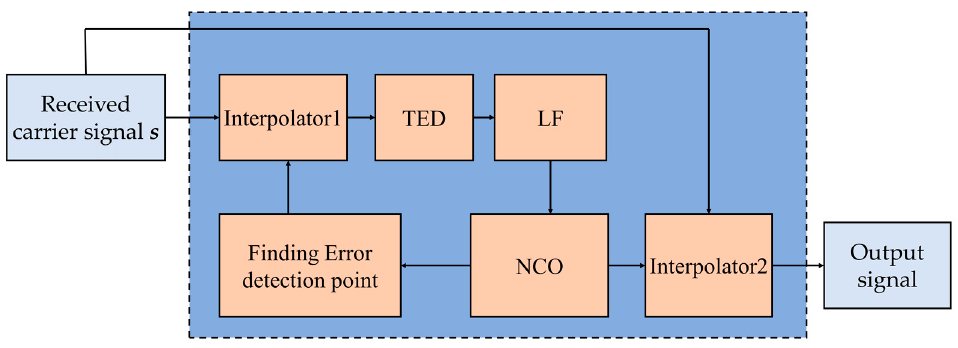
Figure 3. The structure of carrier-based Gardner algorithm.